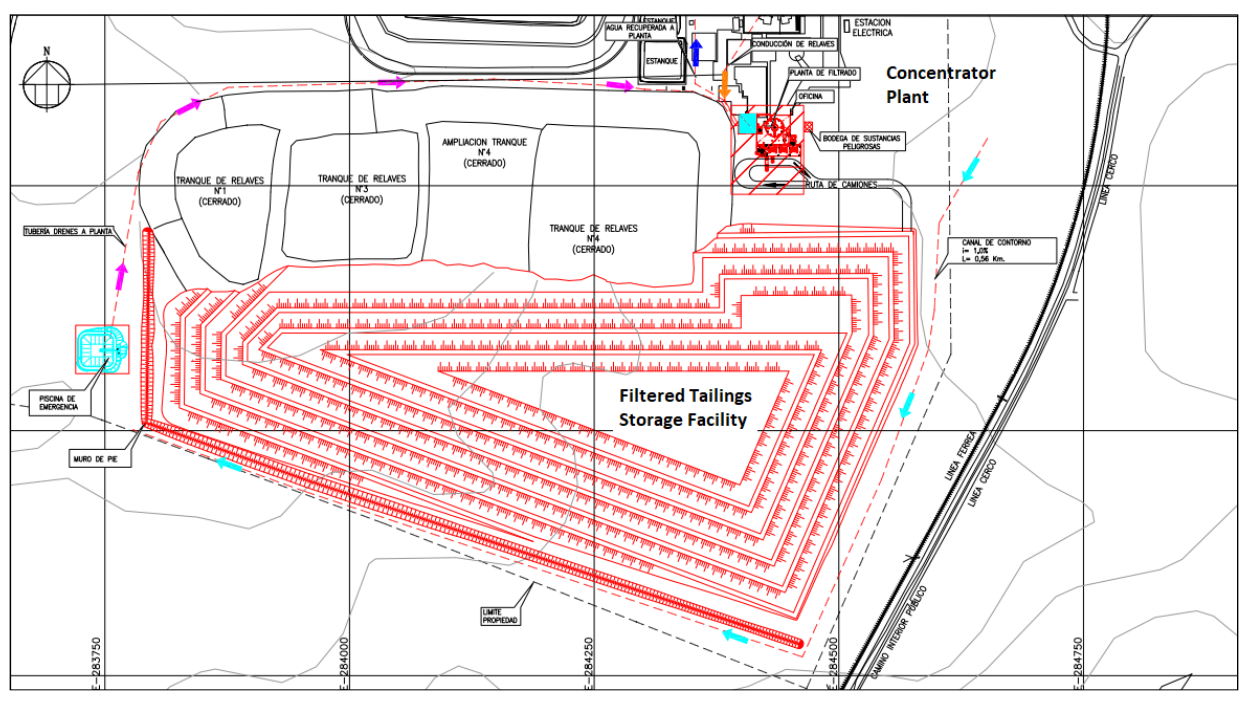
Figure 46. Tambillos Filtered Tailings Storage Facility Layout [48,66].